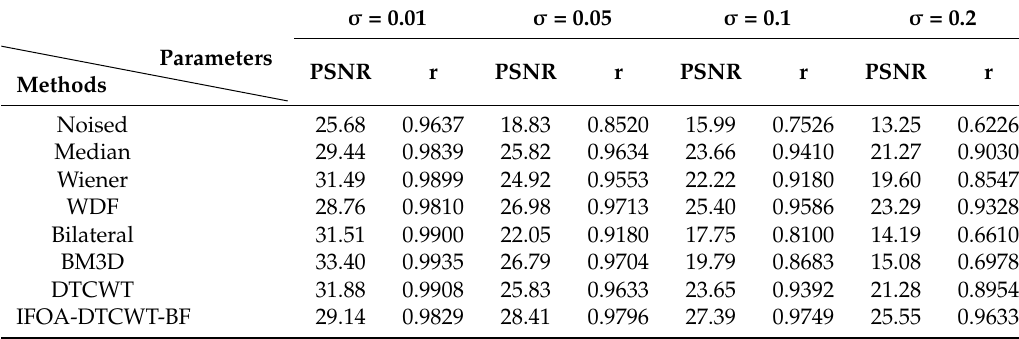
Table 5. Comparison of the six methods (Lena with Speckle noise).